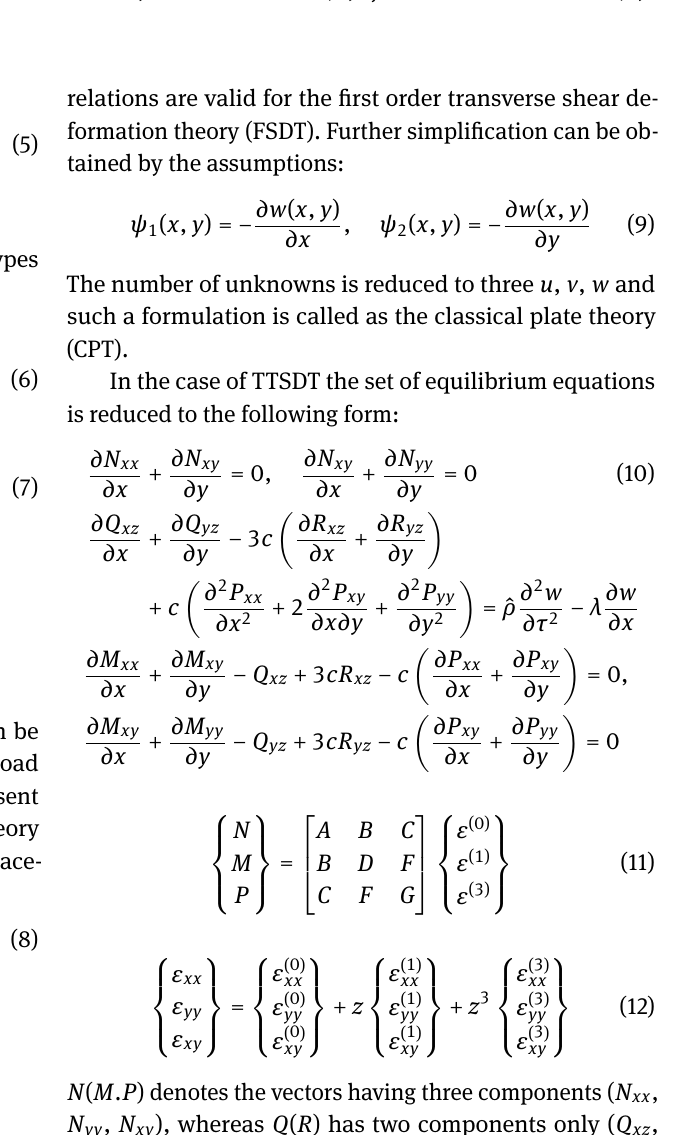
Figure 3: Configurations of cross-sections reinforced with carbon nanotubes: a) uniform distribution, b) symmetric distribution FG – X, c) symmetric distribution FG –